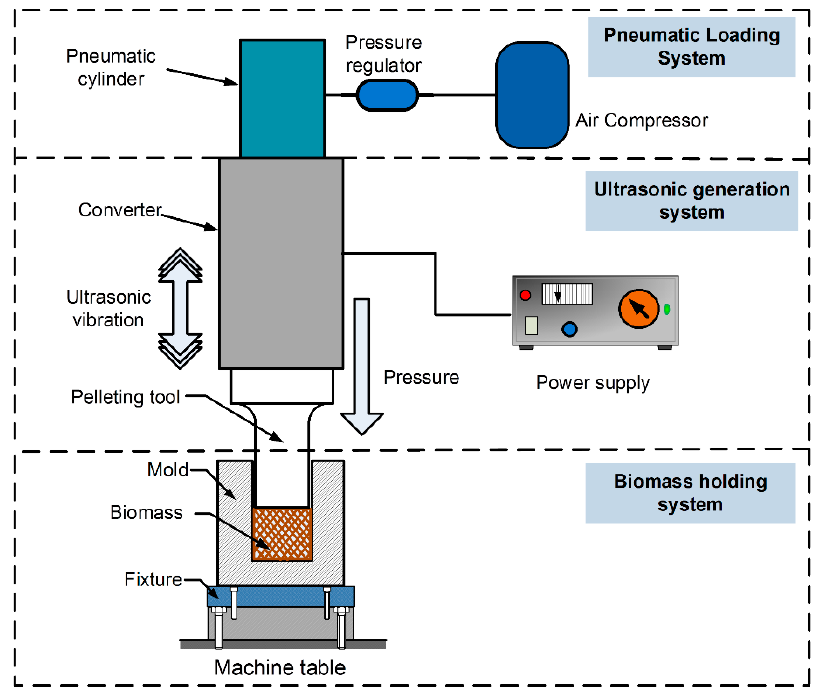
Figure 1. The illustration of the experimental set-up for ultrasonic vibration-assisted (UV-A)